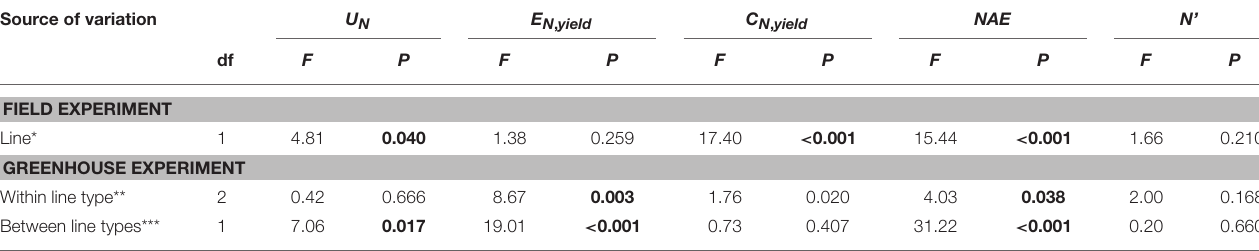
TABLE 7 | ANOVA for N accumulation efficiency and its components in the field (2015) and greenhouse (2014). Source of variation U N E N , yield C N , yield NAE N’ df F P F P F P F P F